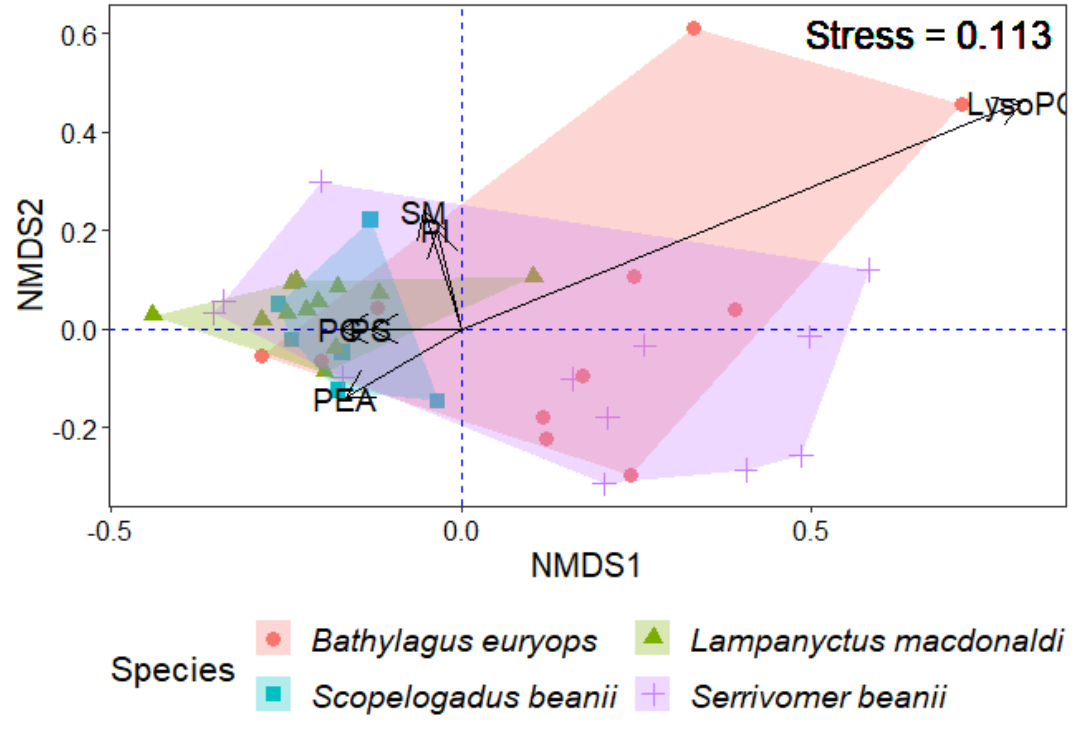
Figure 5. NMDS ordination of individual phospholipid classes in muscles of mesopelagic fish species ( Bathylagus euryops , Lampanyctus macdonaldi , Scopelogadus beanii , Serrivomer beanii ) living at different depths in the Irminger Sea (North Atlantic). Abbreviations: phosphatidylcholine (PC), phosphatidylethanolamine (PEA), phosphatidylserine (PS), phosphatidylinositol (PI) and lysophos- phatidylcholine (LysoPC), sphingomyelin